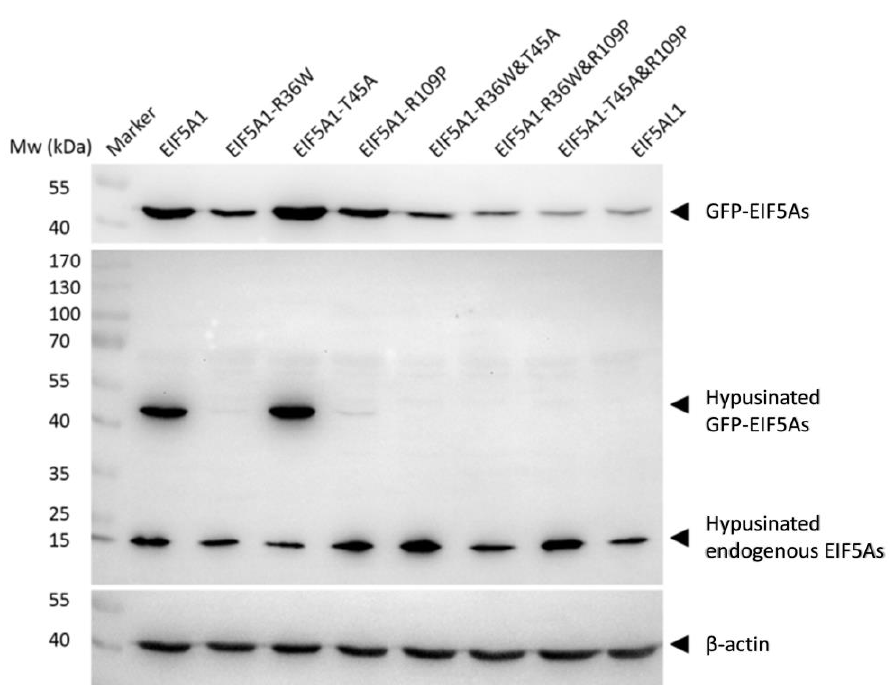
Figure 5. The hypusine modification levels of EIF5A1, EIF5AL1, and EIF5A1 mutant proteins. HeLa cells were transfected with EIF5A1, EIF5AL1 and EIF5A1 mutant plasmids, cells were harvested and lysed at 48 h after transfection. The proteins were extracted, and hypusine modification levels of EIF5A1, EIF5AL1, as well as EIF5A1 mutant proteins were determined by immunoblot analysis. 2.5. The Protein Stability of EIF5A1, EIF5AL1, and EIF5A1 Mutants